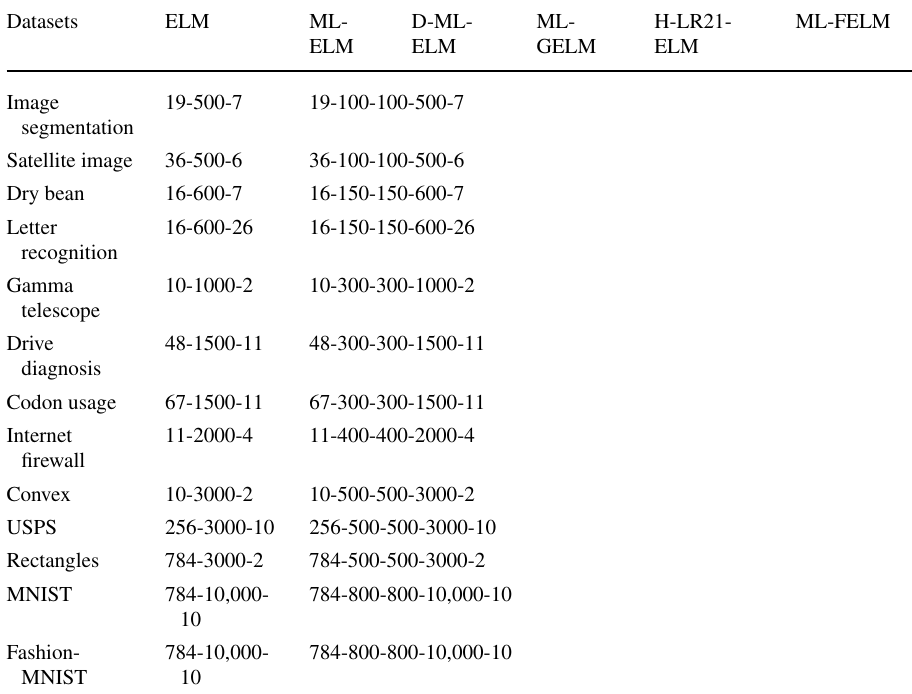
Table 2 The network architecture of ELM,